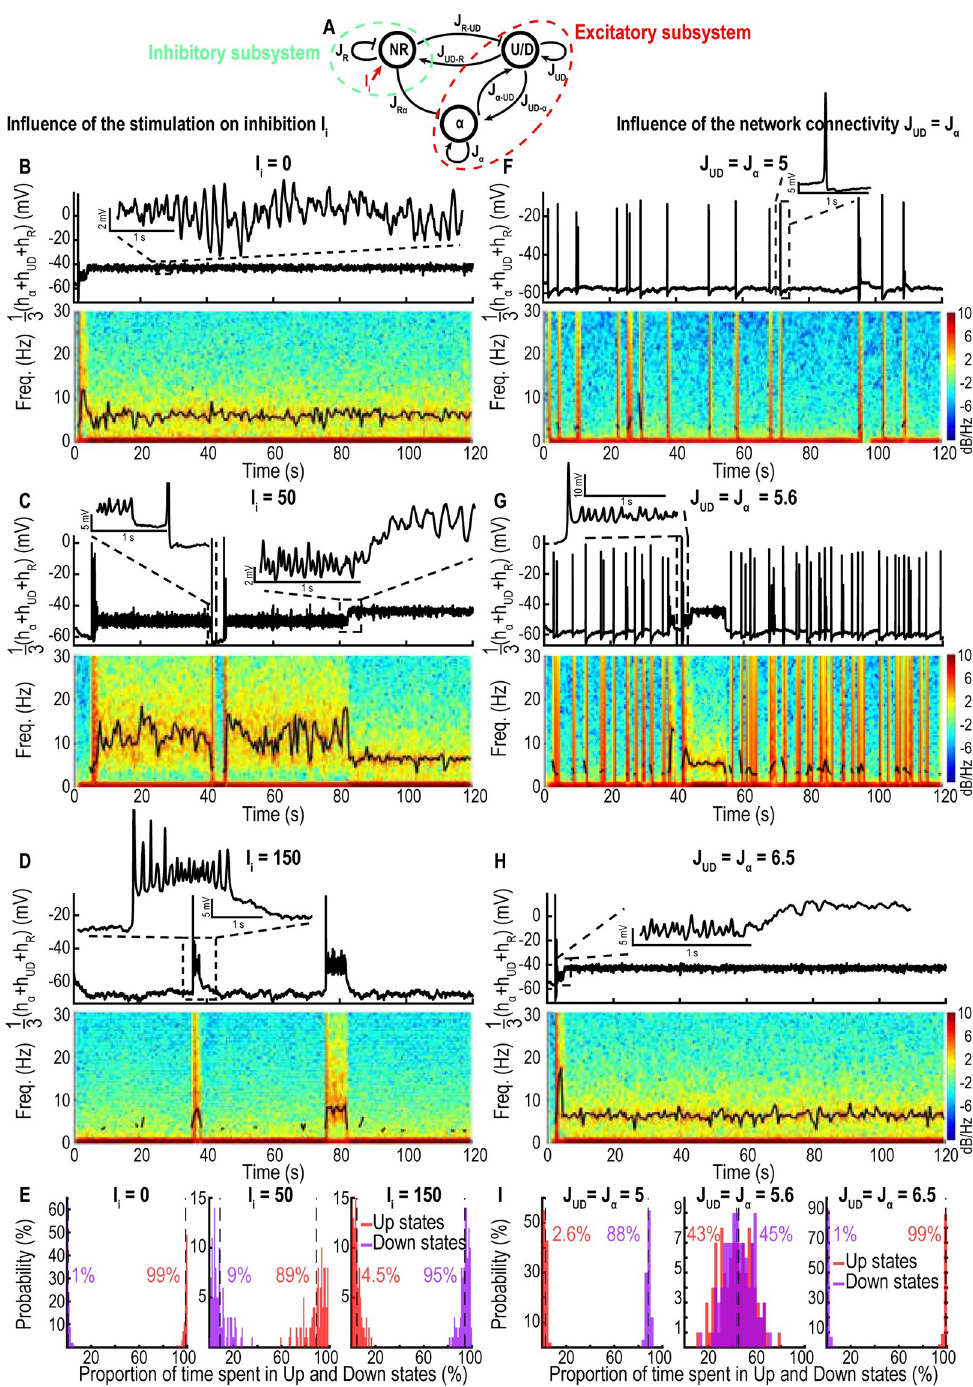
Fig 6. Three compartment model exhibiting Up-Down states and α -band in the Up state. A: Schematic of connectivity between the two excitatory ( α , U / D ) and inhibitory ( NR ) components. B-D: Time-series of the sum of the three populations voltage h α + h UD + h R (upper) and spectrograms (lower) with position of maximum of the oscillatory band (black) for J UD = J α = 6.5 and I i = {0, 50, 150}. E: Fraction of time spent in the Up and Down states for the three values of I i . F-H: Time-series of h α + h UD + h R (Upper) and spectrograms (lower) for I i = 0 and J UD = {5, 5.6, 6.5}. I: Fraction of time spent in the Up and = J α . Timescales for U / D : τ = 0.025s, τ = 0.5s, τ = 0.3s; for NR and α : τ = 0.005s, τ = Down states for the three values of J UD r f r 0.2s, τ = f